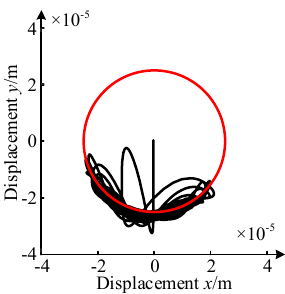
Figure 10. Axis trajectory under upper and lower unit failure. Similarly, the impact-rubbing phenomenon of the rotor can be divided into the bouncing stage and eddy stage, when the upper unit fails. When the rotor falls directly on the fixed ring, it bounces and collides firstly and then vortexes repeatedly forward/back- ward. Similarly, the rotor displacement, phase trajectory, rubbing force, and electromag- netic force were extracted, as shown in Figure 11.